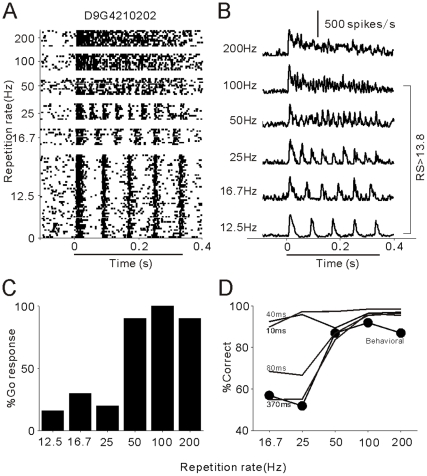
An example of spike activities of A1 units when the cat was discriminating the click-trains.(A) Raster plots of neural spikes in 50 trials of standard stimuli (12.5 Hz) and 10 trials of target stimuli (16.7–200 Hz). Stimulus duration is indicated by the horizontal bar below the time axis. (B) PSTH representing the mean firing rate (1-ms bin, smoothed by Gaussian function with 5-ms SD) in each stimulus condition. (C) Cat's behavioral response (% Go) during the unit recording. (D) Psychometric and neurometric functions. Filled circle marked line represents the psychometric function. Thin lines represent the neurometric functions calculated from this neuron based on different temporal resolutions.